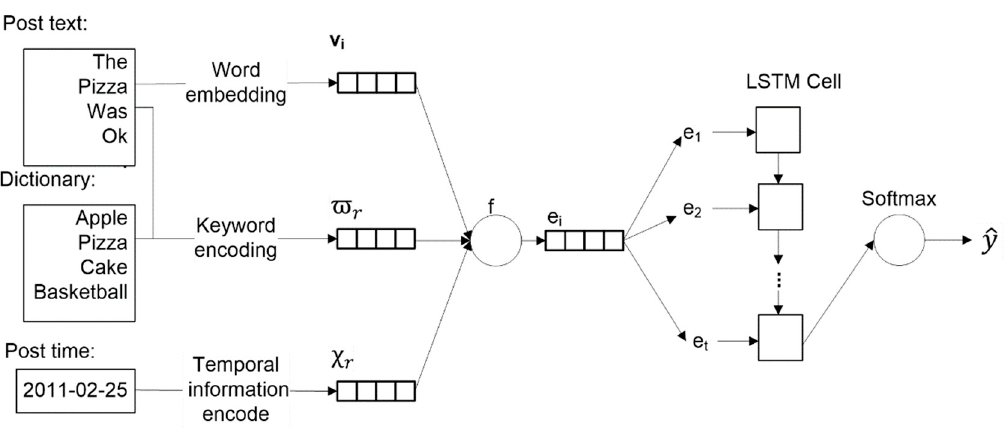
Figure 1. The proposed ALSTM (activity LSTM) model.